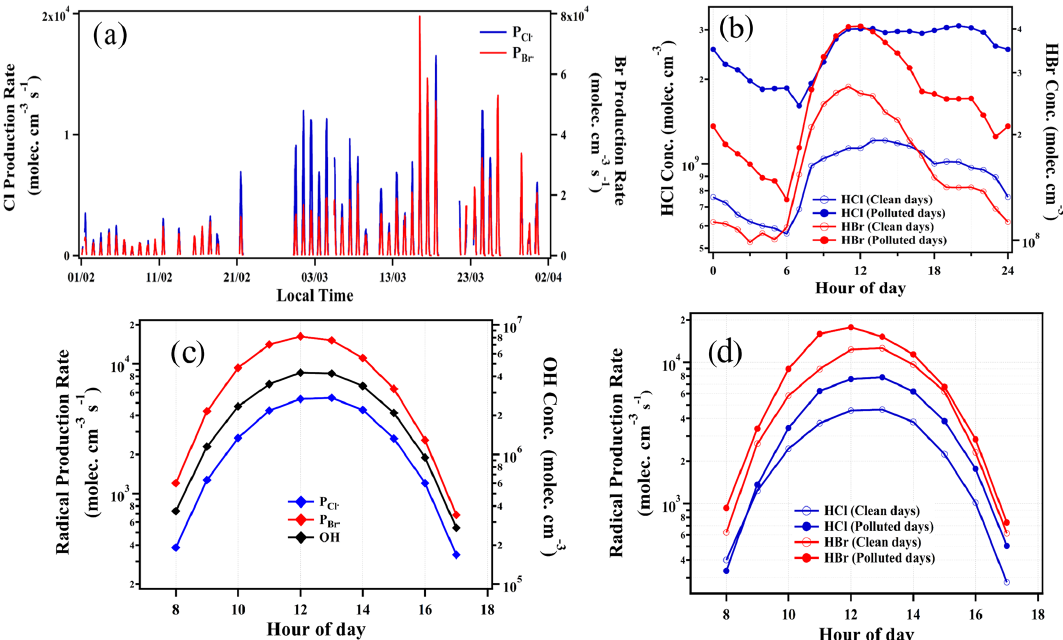
Figure 8. Time series of calculated production rates of Cl and Br radicals during the observation period (a) ; diurnal variations of HCl and HBr concentrations on clean and polluted days (b) ; diurnal variations of production rates of Cl and Br radicals from 08:00 to 17:00, together with calculated OH radical concentrations (c) ; and production rates of Cl and Br radicals on clean and polluted days (d) . The clean and polluted days were classified as daily PM 2 . 5 < 75µgm − 3 and PM 2 . 5 ≥ 75µgm − 3 , respectively. The data points are hourly average intervals and measured during observation periods from 1 February to 31 March